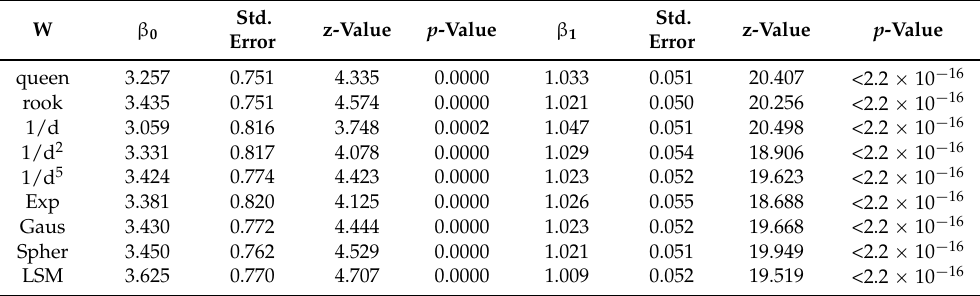
Table 6. Model coefficient estimates of SEM for nine spatial weight